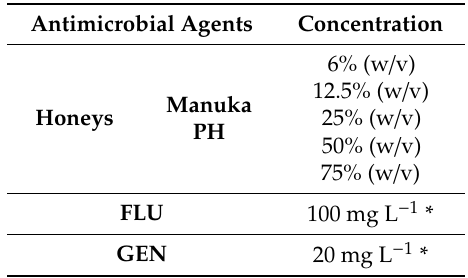
Table 1. Tested concentrations of honey (Portuguese heather (PH) and manuka), commercial antifungal agent (FLU) and commercial antibiotic agent (GEN)